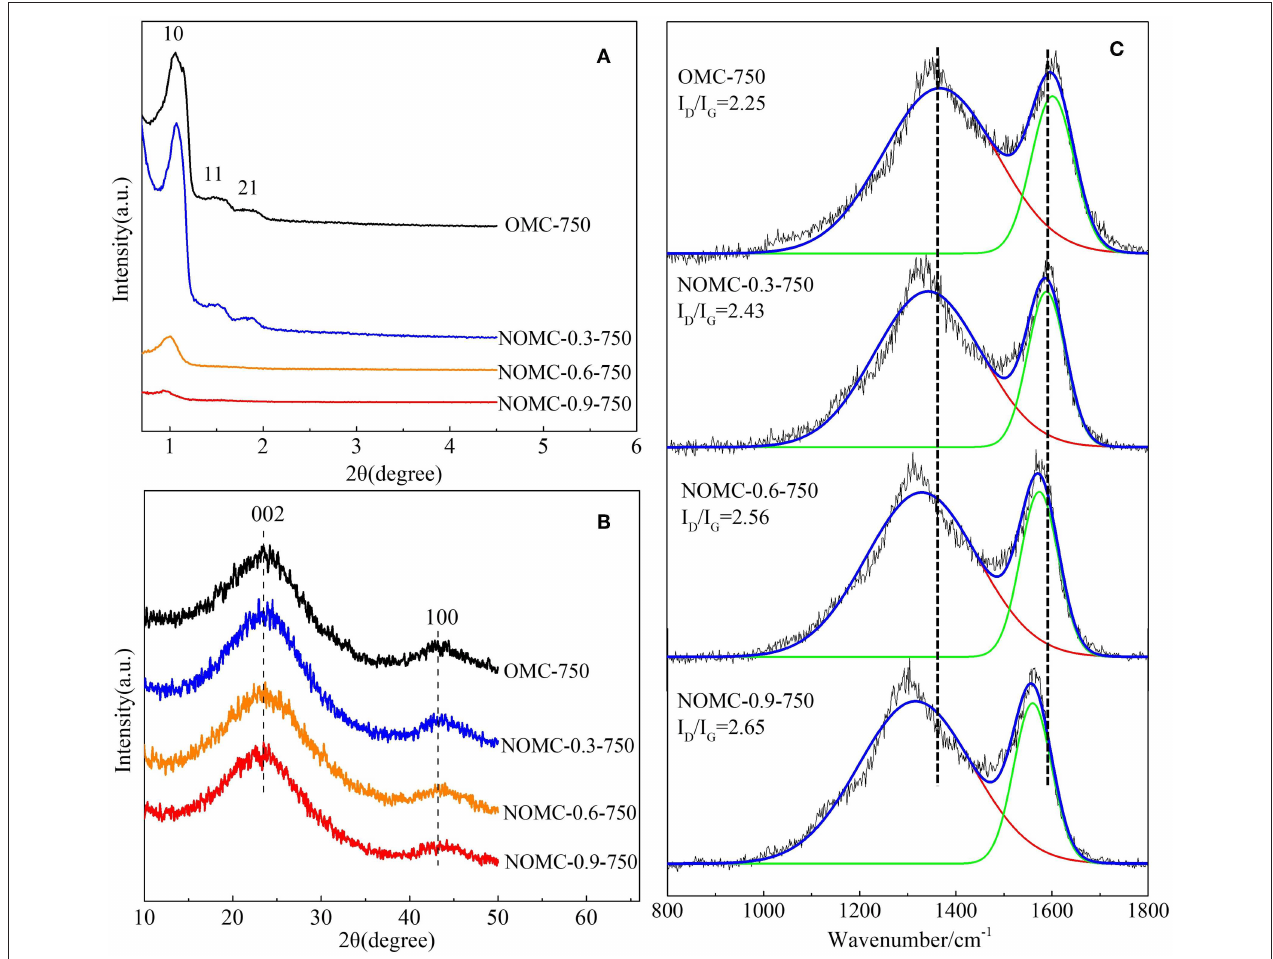
FIGURE 2 | Small–angle (A) , wide–angle (B) XRD patterns and Raman spectra (C) of OMC and NOMCs, ordered mesoporous carbon with different nitrogen–doping